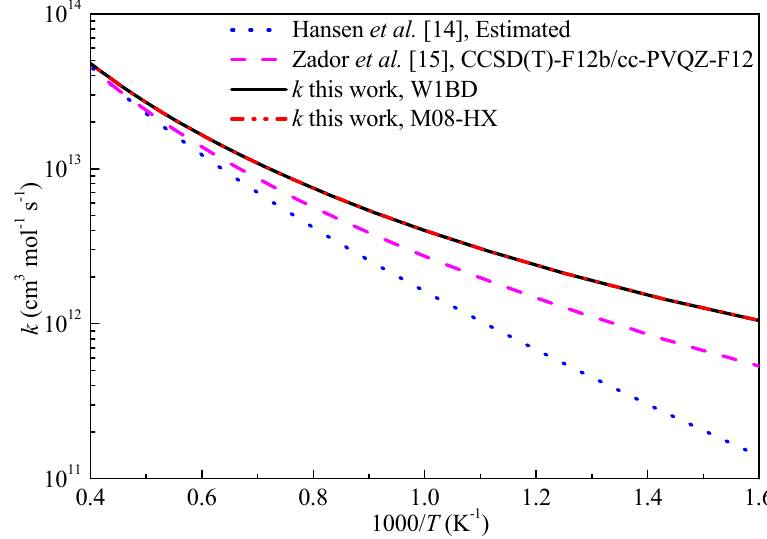
Figure 7. Computed rate constants for the H-abstraction reaction of propyne with OH at propargyl site.